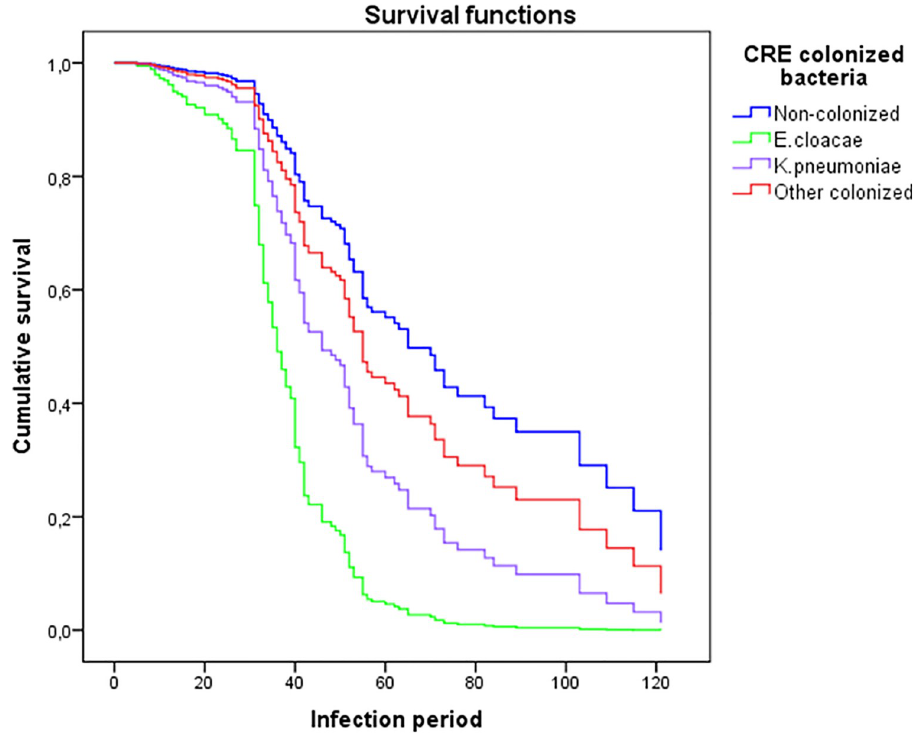
Fig 2. Multiple Cox regression analysis of the estimated survival in patients with CRE-colonized bacteria compared with controls.